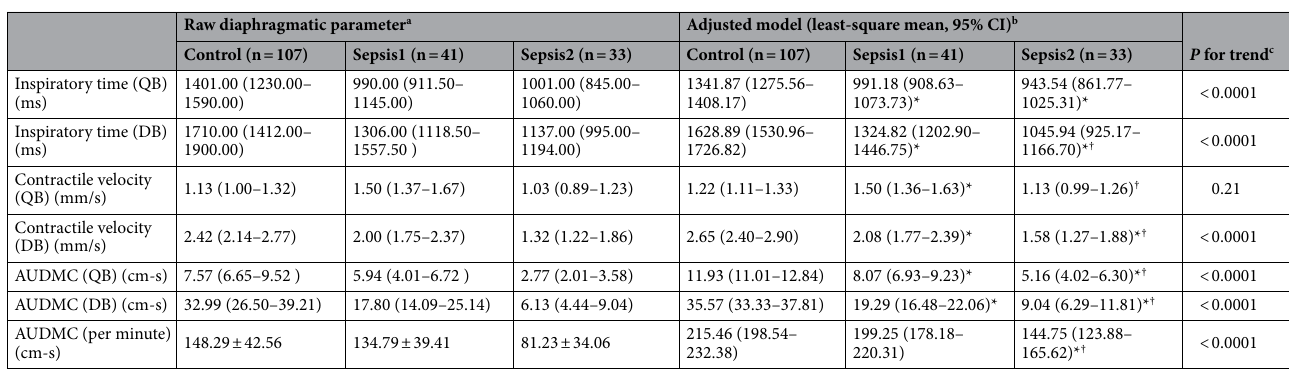
Table 3. Diaphragmatic contractile velocity and AUDMC measured by ultrasound in three groups. The above analyses were adjusted for sex, age, BMI, MAP, hypertension and diabetes, rather than using the raw data of diaphragmatic parameters directly. * P < 0.05 compared with control group; † P < 0.05 compared with sepsis group 1. a All raw data was presented as median (IQR) or mean ± SD for continuous variables. b The adjusted least-square mean and 95% CI were calculated by covariance analysis (CI = confidence interval). c P for trend of diaphragmatic ultrasound parameters across sepsis severity were calculated based on generalized linear